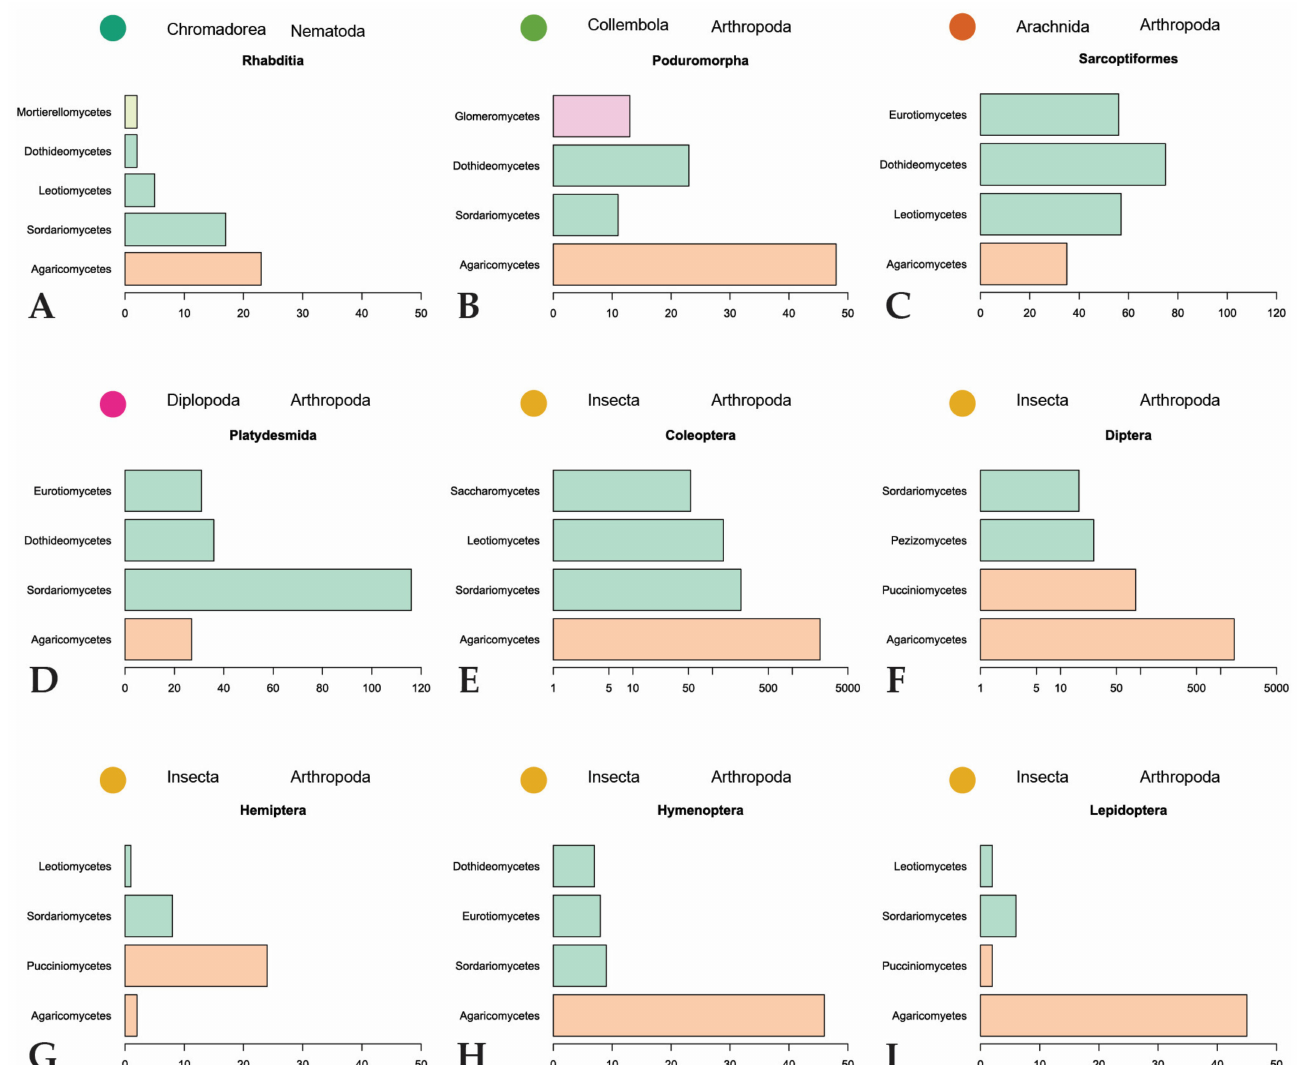
Figure 6. Summary of major invertebrate orders and representatives of the four most represented fungal classes they feed on. Fungal classes are colored by phylum as in Figure 3. ( A , B , G – I ): scales to 50; ( C , D ): scales to 120; ( E , F ): scales are